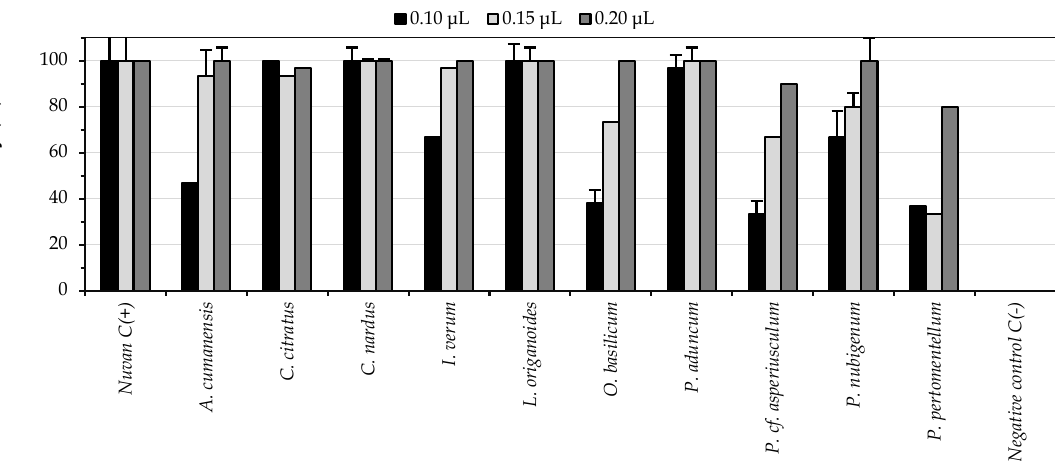
Figure 5. Contact toxicity results of the 10 EOs that produced fumigant mortalities less than 10%. The results of the contact and fumigant toxicities of the 14 EOs that presented mortality rates greater than 25% in the fumigant test are illustrated in Figure 6. It was observed that 13 EOs exhibited fumigant and contact activities, while H. mexicanum EO was the only one that did not cause contact mortality. The EOs from C. × sinensis , C. sempervirens and H. myricariifolium , although they were toxic by contact in all the quantities evaluated, caused higher mortalities when they were evaluated as fumigants at a concentration of 500 µ L/L of air. In contrast, the oils from S. viminea , M. septentrionalis , Ocotea sp., and C. album , although they exhibit fumigant activity at the concentrations evaluated, caused higher mortality rates when the oils were applied directly to the insect at all the quantities tested.